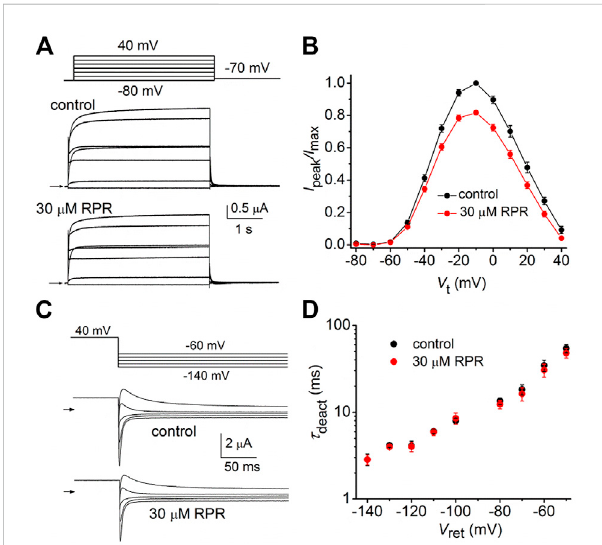
FIGURE 5 Effects of RPR on C-del hERG1a channel currents. (A) Voltage pulse protocol and corresponding C-del hERG1a channel currents recorded from an oocyte before (control) and after treatment with 30 µM RPR. Horizontal arrows indicate zero current level. (B) Averaged data for I peak -V relationships. RPR decreased I peak ( n = 5; p < 0.001, 2 way ANOVA) (C) Voltage pulse protocol and corresponding tail currents recorded before (control) and after treatment with 30 µM RPR. Small horizontal arrows indicate zero current level. (D) RPR did not alter τ deact ( n = 5).